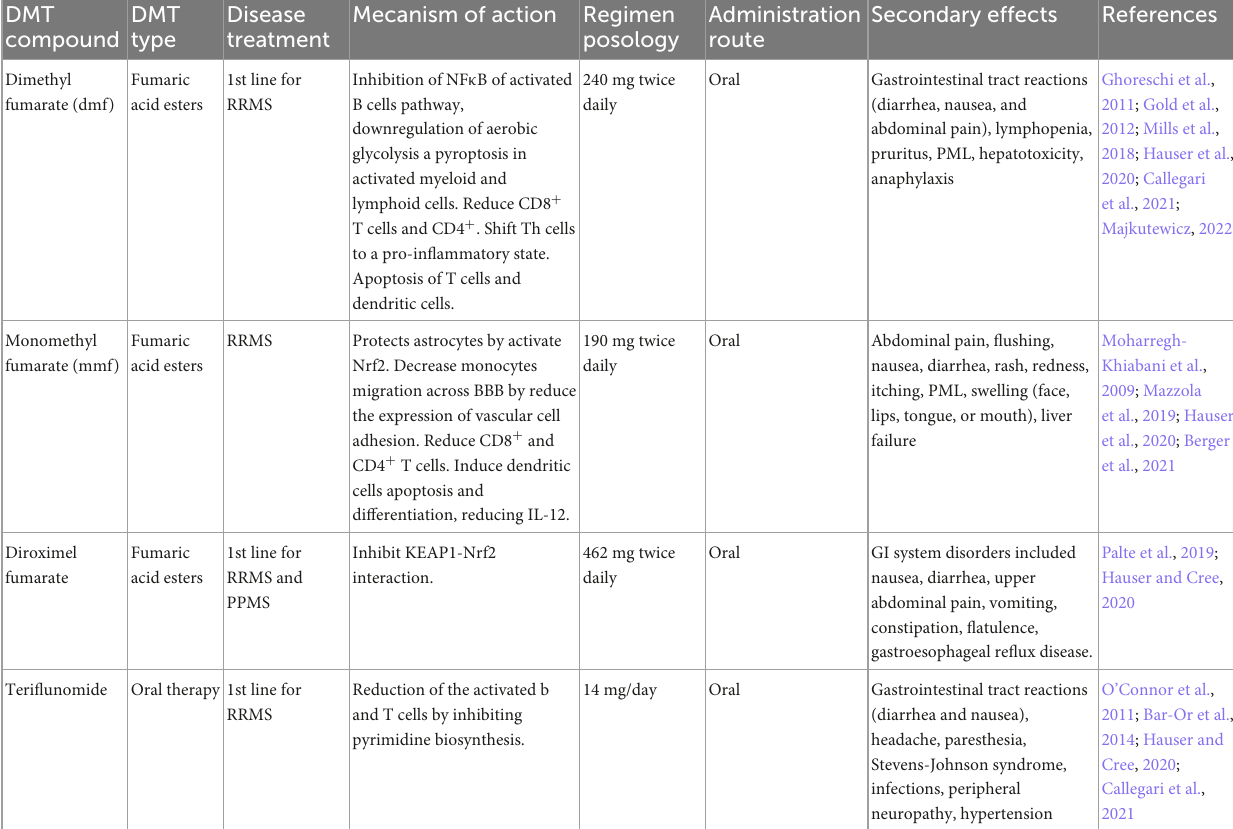
TABLE 3 Oral immunomodulatory therapies.